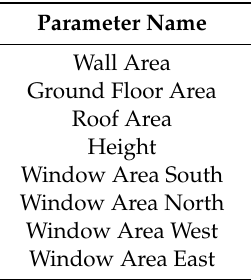
Table 3. Input parameters in Study 02 and 03.